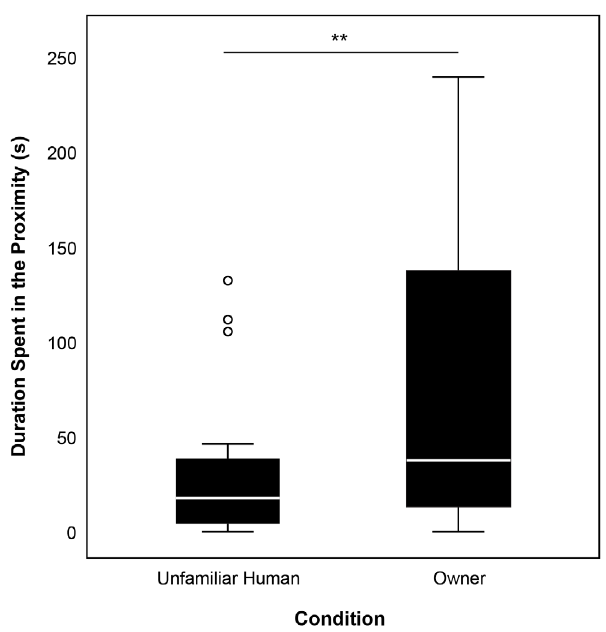
Figure 6. Duration spent in the proximity of the owner and the unfamiliar human – Experiment 2. Graph depicts box plots of duration spent in the proximity of the unfamiliar human (cRO) and of the owner (cSO), respectively. For each box plot, median values are indicated by the line within the box. The box represents 50% of the values (25th and 75th percentiles), with the upper bar representing the 90th percentile and the lower bar representing the 10th percentile. Circles indicate outliers. ** represents P # 0.01.